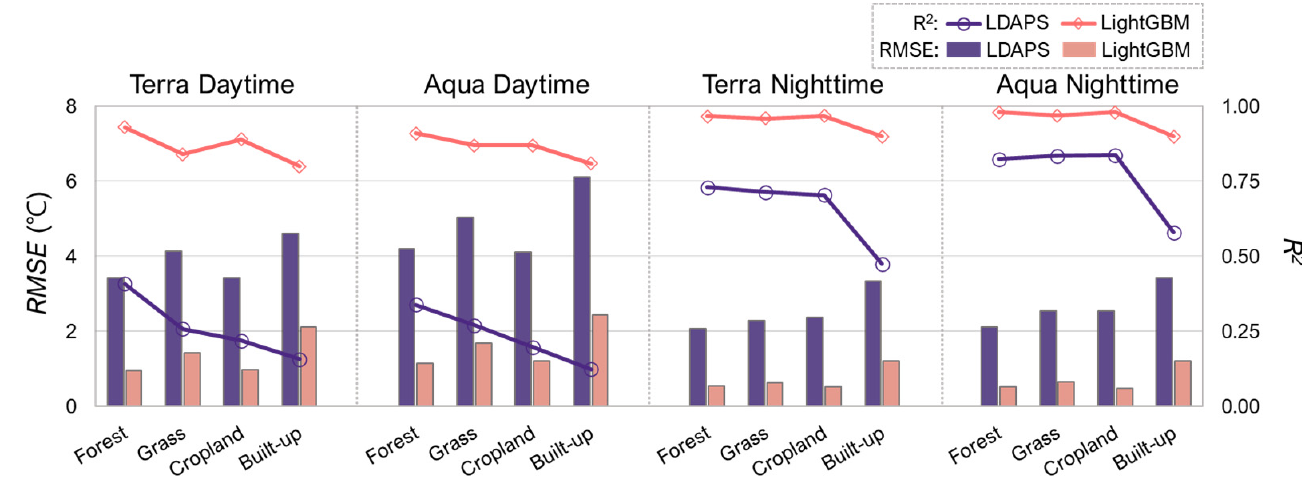
Figure 5. Performance of the LDAPS and the proposed LightGBM model by land cover for four clear-sky LSTs (i.e., Terra and Aqua for daytime and nighttime). The performance of the LightGBM model by land cover was calculated from the SPCV results.